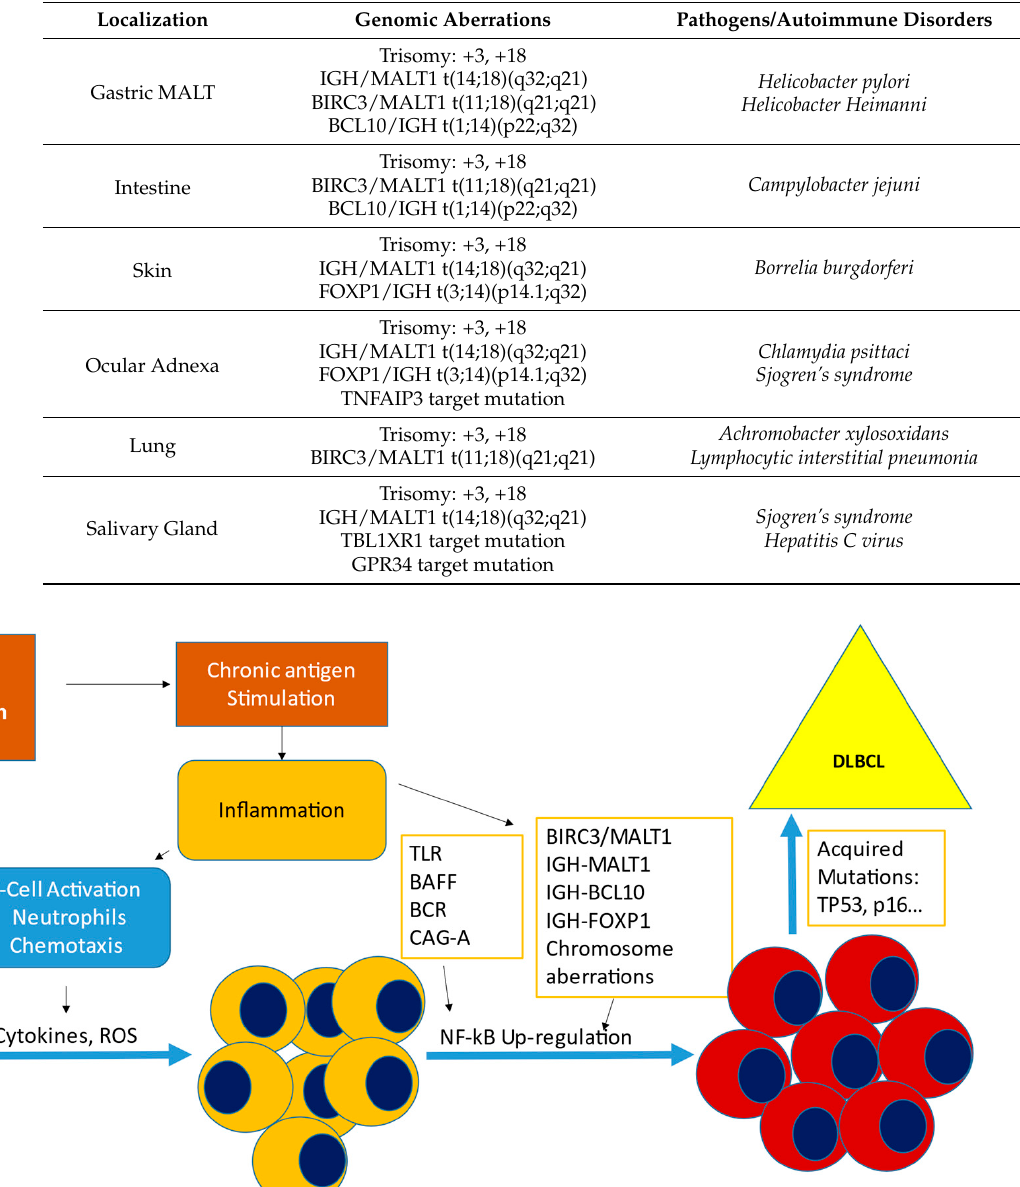
Table 1. Site-related pathogens and genetic mutations.